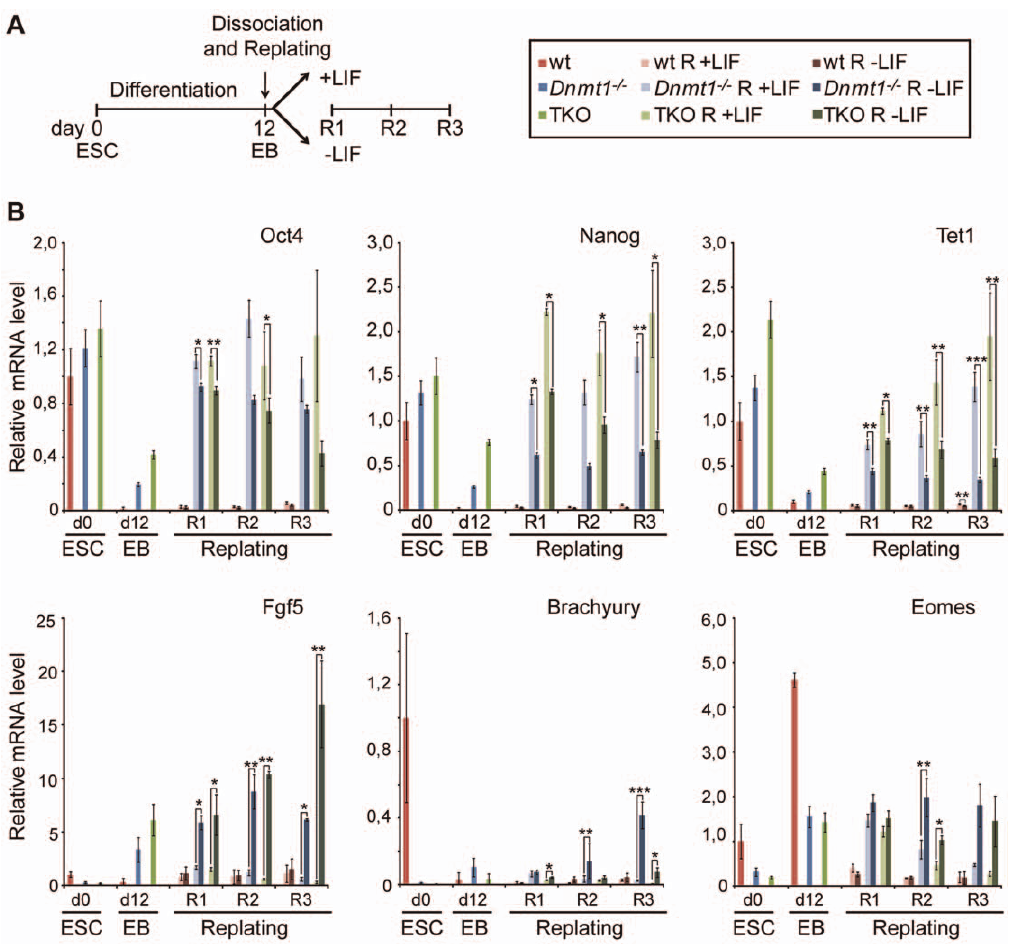
Figure 6. LIF signaling induces reversion of cells from Dnmt1 2 / 2 and TKO EBs to the ESC state. (A) Overview of experimental set up. Day 12 EBs were dissociated and their cells were plated and further cultured for three days (R1–3) in the presence or absence of LIF. (B) Transcript levels of pluripotency associated genes Oct4 , Nanog and Tet1 , as well as differentiation marker genes Fgf5 , Brachyury and Eomes were determined by RT-qPCR in undifferentiated ESCs (day 0), day 12 EBs and 1, 2 and 3 days after replating (R1–3). Wild type, Dnmt1 2 / 2 and TKO samples are represented in shades of red, blue and green, respectively, as indicated in the box at the upper right corner. Mean values relative to wt ESCs (day 0) and standard errors are from three independent biological replicates. Asterisks indicate significance levels: * p , 0.05; ** p , 0.001; *** p , 0.0001 (Student